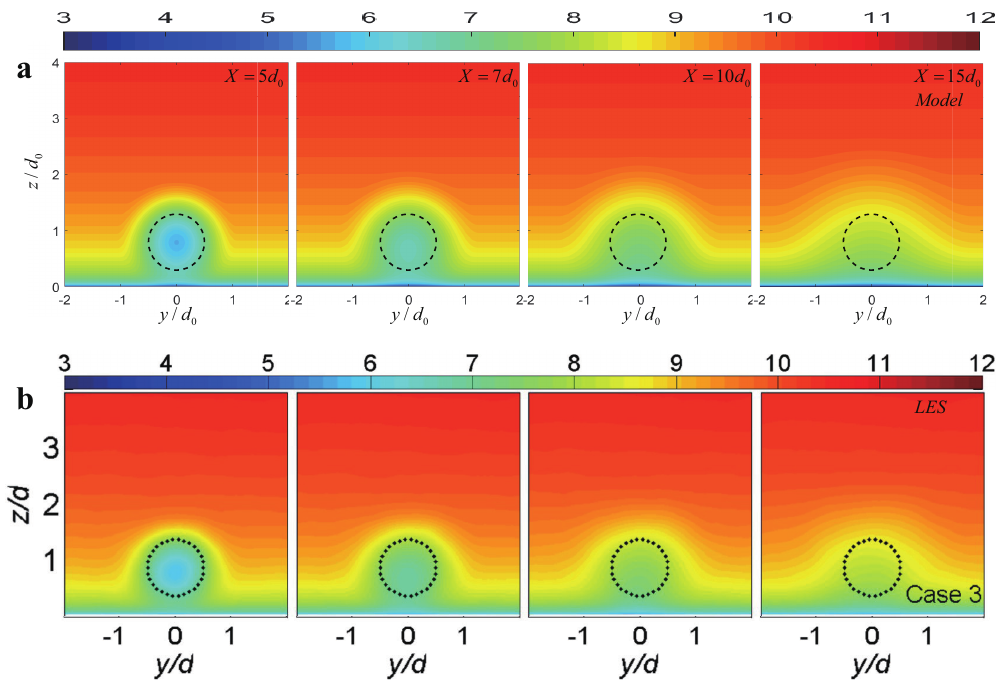
Figure 15. Y – Z views of the streamwise velocity estimated by ( a ) the model and ( b ) LES (reproduced with permission from Wu and Porté-Agel